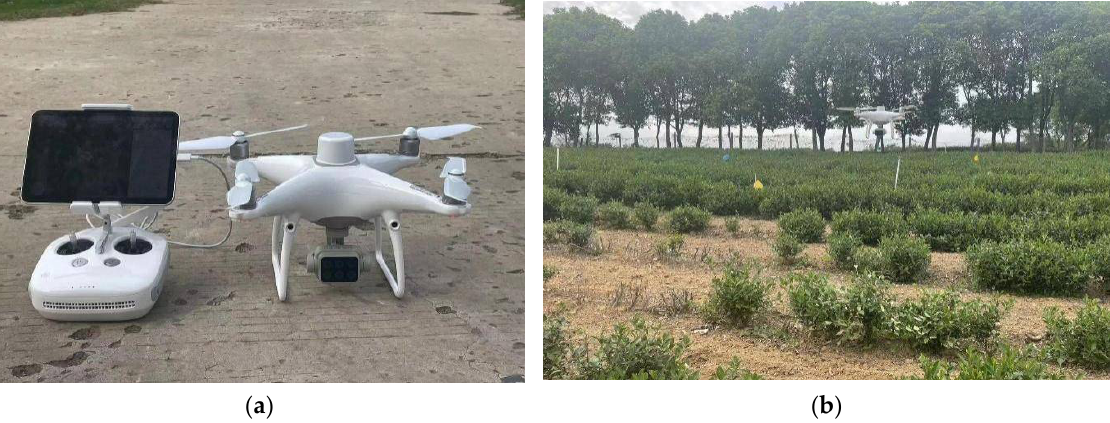
Figure 2. Types of UAVs and sensors used in this study: ( a ) quad-rotor UAV with RGB sensor, DJI Phantom 4 RTK, ( b ) flying operations.